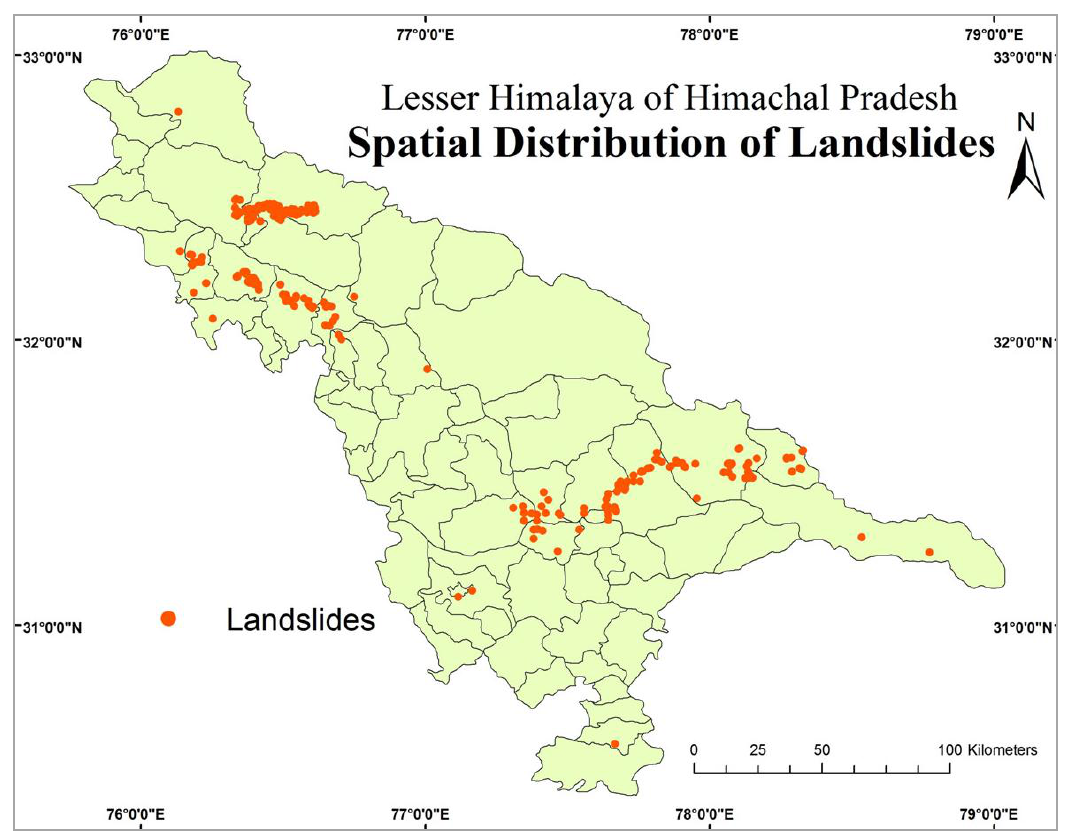
Fig. 2. Spatial distribution of landslides (compiled by Authors based on Geological Survey of